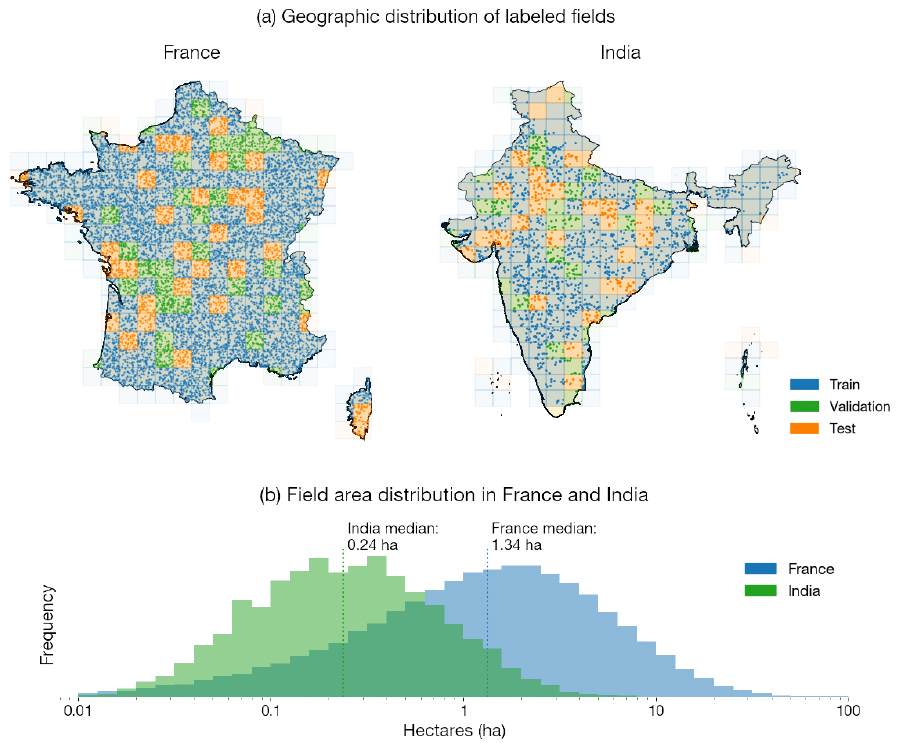
Figure 2. CharacteristicsofFranceandIndiadatasets. ( a ) The locations of labeled fields are plotted as points on maps of France and India. We also visualize how images are split into training, validation, and test sets in geographic blocks. ( b ) Histograms of field areas on a log x -axis show that France fields are on average 5.6 times larger than India